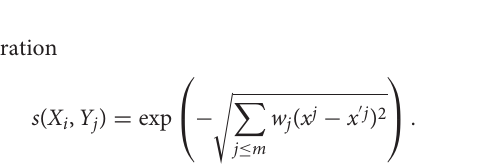
FIGURE 3 | Schematic of prior derivation using similarity-weighted